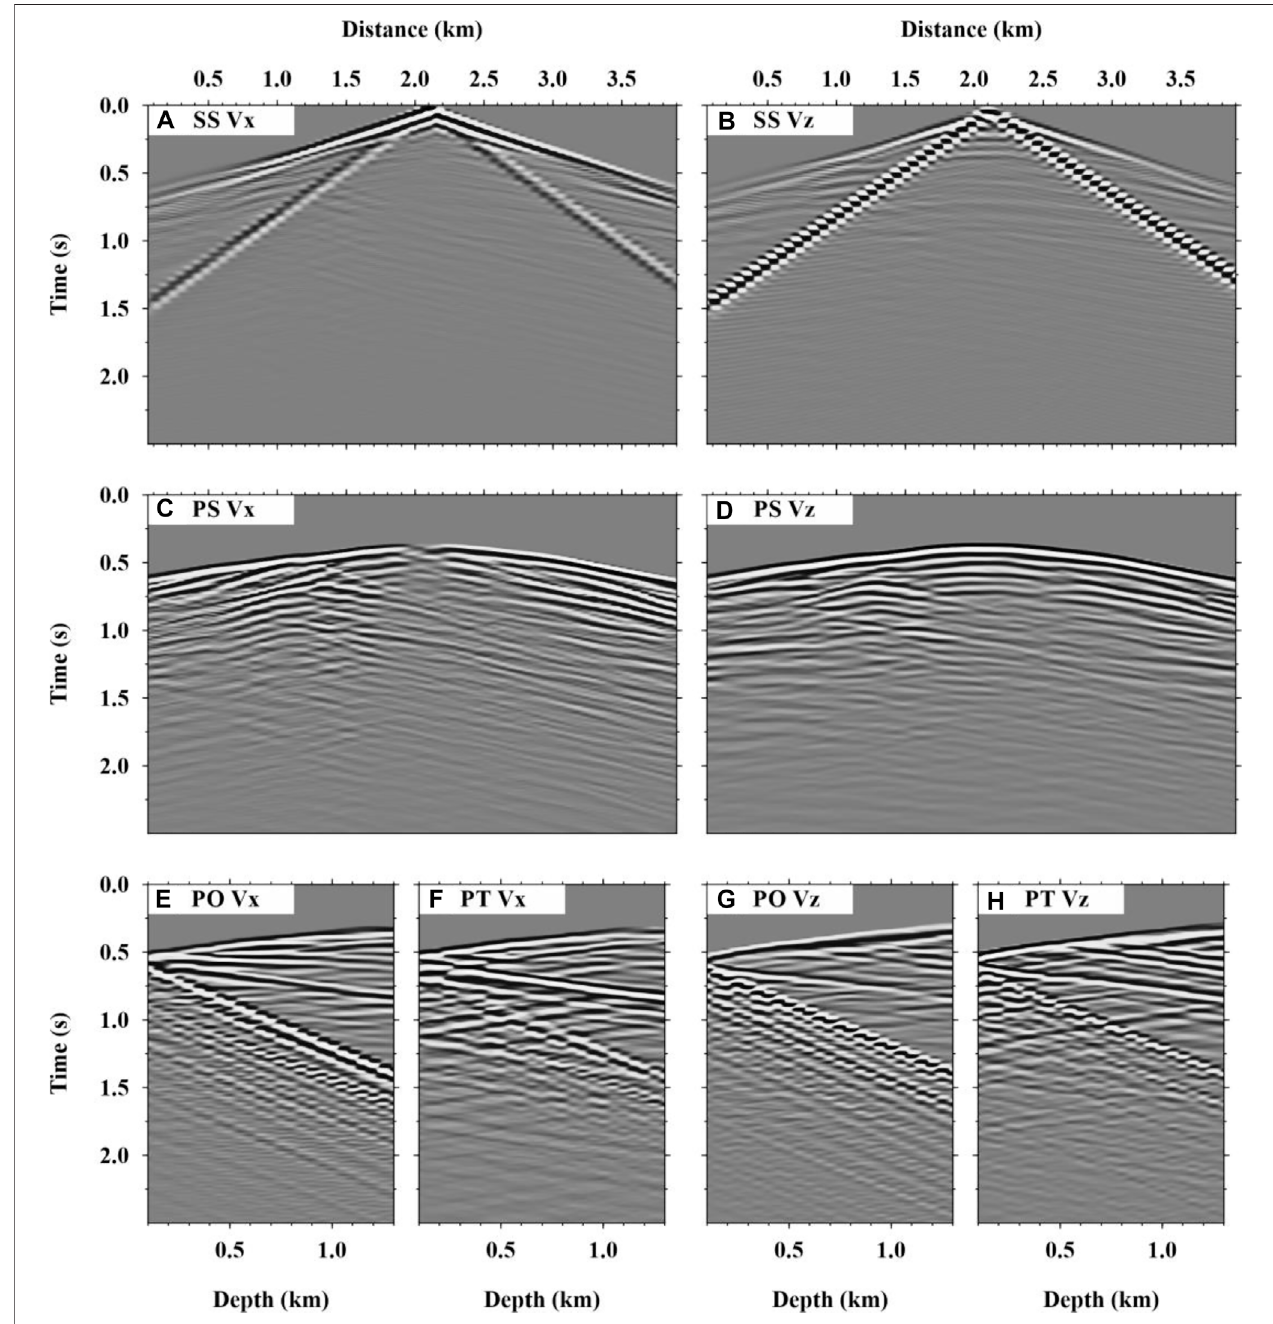
FIGURE 2 | Synthetic seismograms. (A,B) are the Vx and Vz components, respectively, of SS. Similarly, (C,D) are of PS, (E,G) are of PO, and (F,H) are of PT. The data of PT were recorded using the array on the vertical well on the right-hand side of the model.